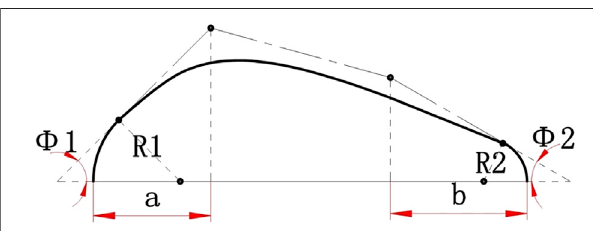
FIGURE 2 | Thickness distribution of round head.